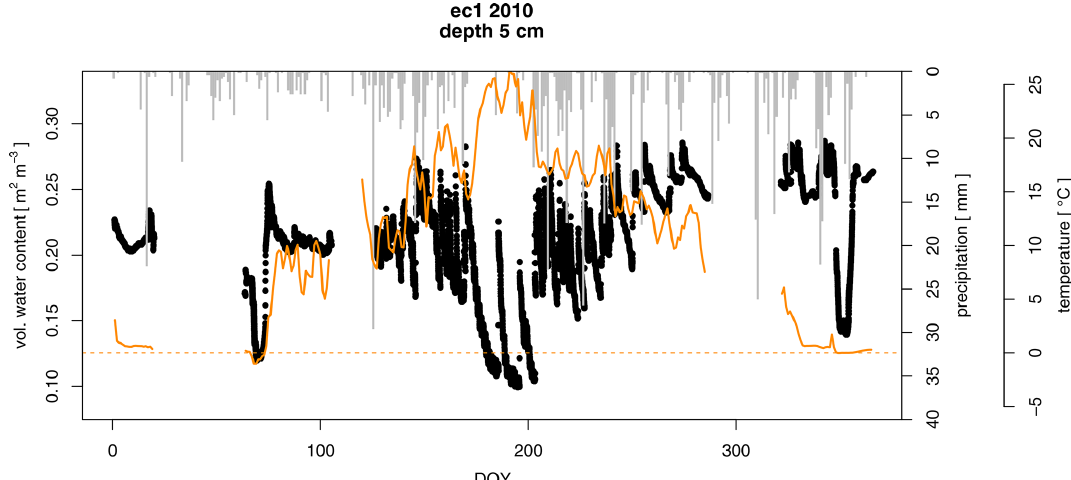
Figure 5. Soil water content (black dots), precipitation (grey bars) and soil temperature (orange line) at research site EC1 in 2010 at 5cm soil depth. The dashed orange line indicates 0 ◦